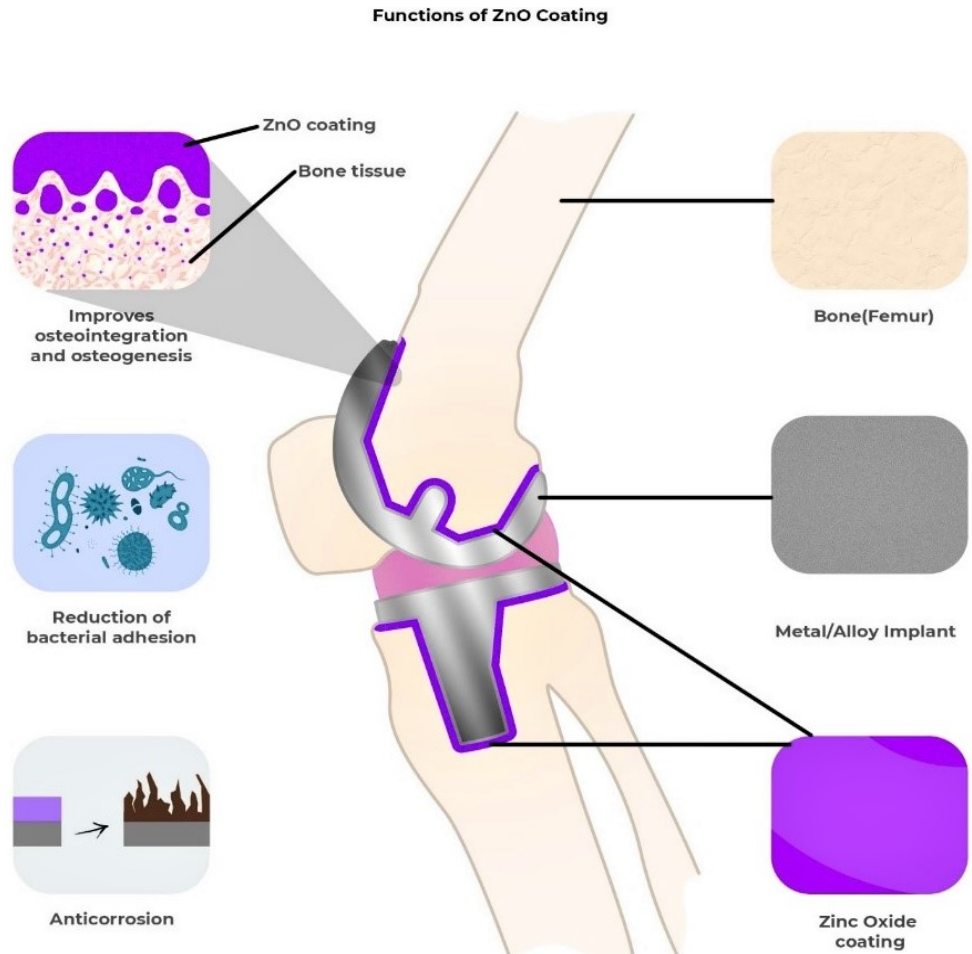
Figure 5. A diagram showing the effects of metal oxide (e.g., ZnO) coating on the orthopedic implant and bone.